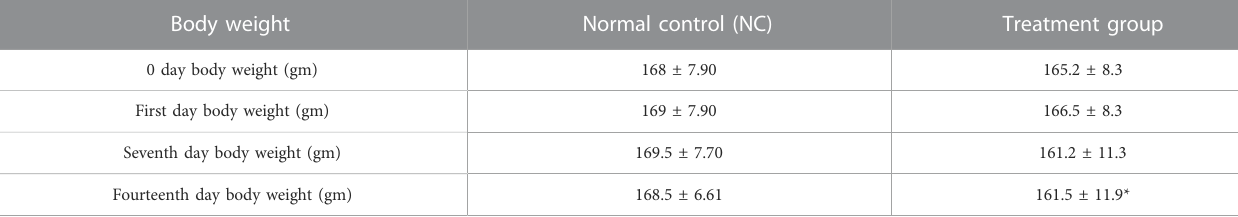
TABLE 2 Effects of treatment (F) on body weight of rats in the acute toxicity study.